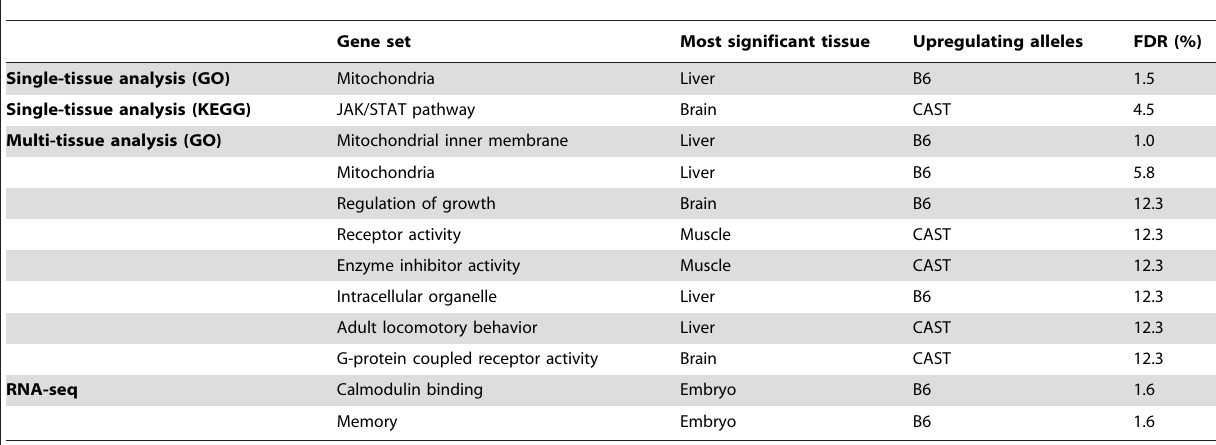
Table 1. Gene sets with significant bias in cis- eQTL